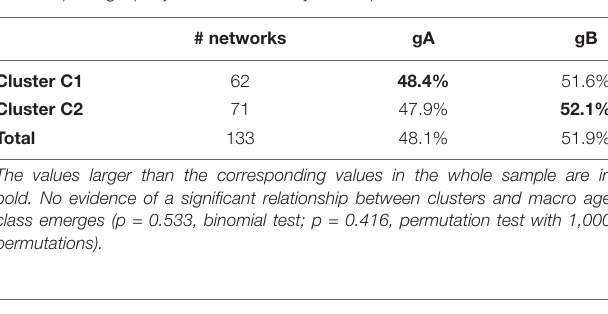
TABLE 5 | Percentage of subjects in the seven age groups for clusters C1 and C2.